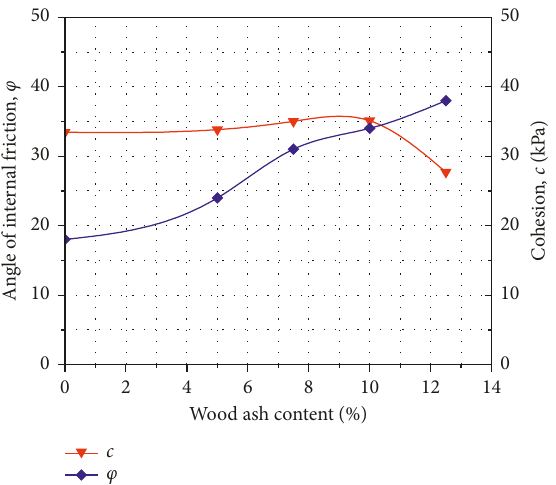
Figure 7: Variation of the shear strength parameters with wood ash.